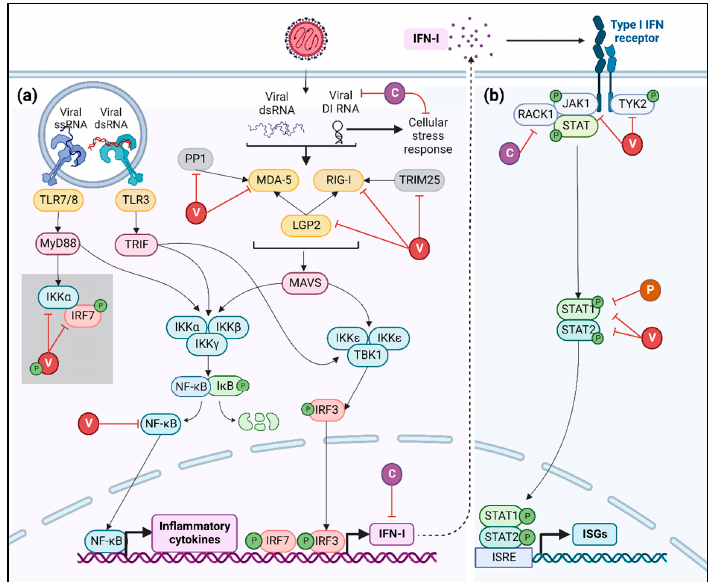
Figure 3. Inhibition of IFN-I cascade. ( a ) Viral RNA recognition by cellular PRR, such as TLRs and RLRs (yellow), activates multiple signaling cascades leading to IFN and NF- κ B expression, which is suppressed by V (red) and C (purple) proteins of MeV at diverse levels as summarized here. In the grey square, the mechanism of inhibition of IRF-7 by V protein observed in pDCs infected by MeV vaccinal strains is presented. Phosphate groups are represented in green. ( b ) IFN-I-dependent signaling is inhibited by MeV V, C and P (orange) proteins acting both on JAK/STAT complex and on STAT1/STAT2 transcription factors.